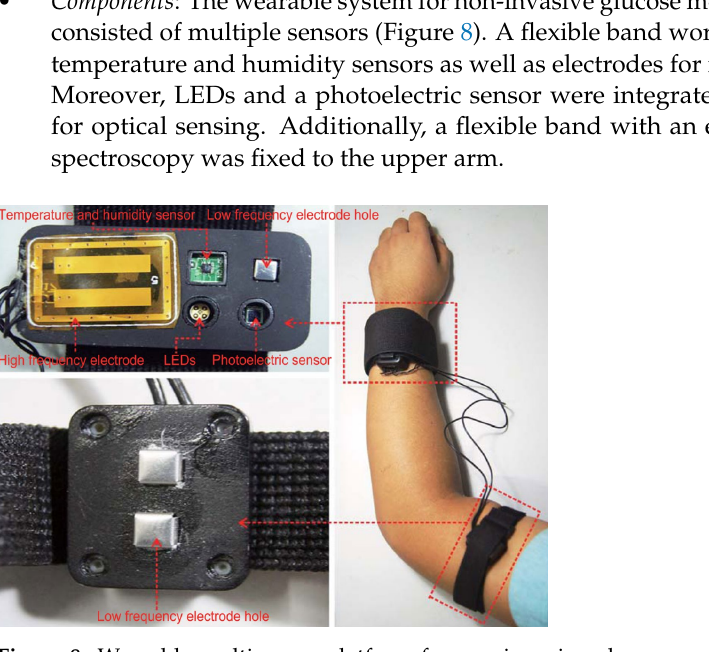
Figure 8. Wearable multisensor platform for non-invasive glucose sensing. The system includes impedance spectroscopy-based sensors (electrodes) as well as optical sensors (LEDs, photoelectric sensor) and humidity and temperature sensors (Reprinted from Ref.